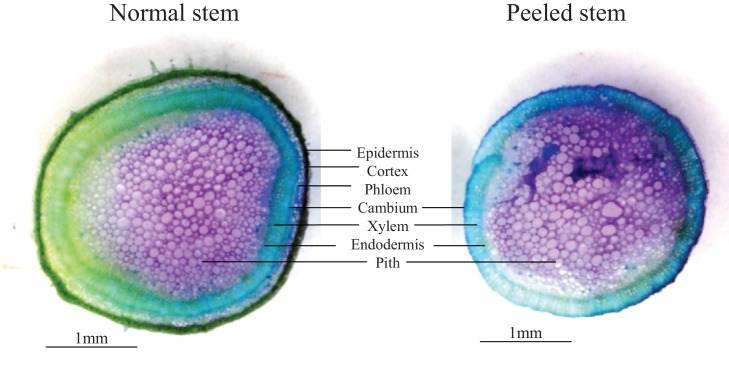
Toluene-blue staining of stem-peeled EV plants at the early bolting stage.Experimental stem peeling as a mimick of feeding patterns observed in the Lytle plot removed epidermis, cortex and phloem cells from the plant. The remaining tissue consisted of xylem and pith cells.